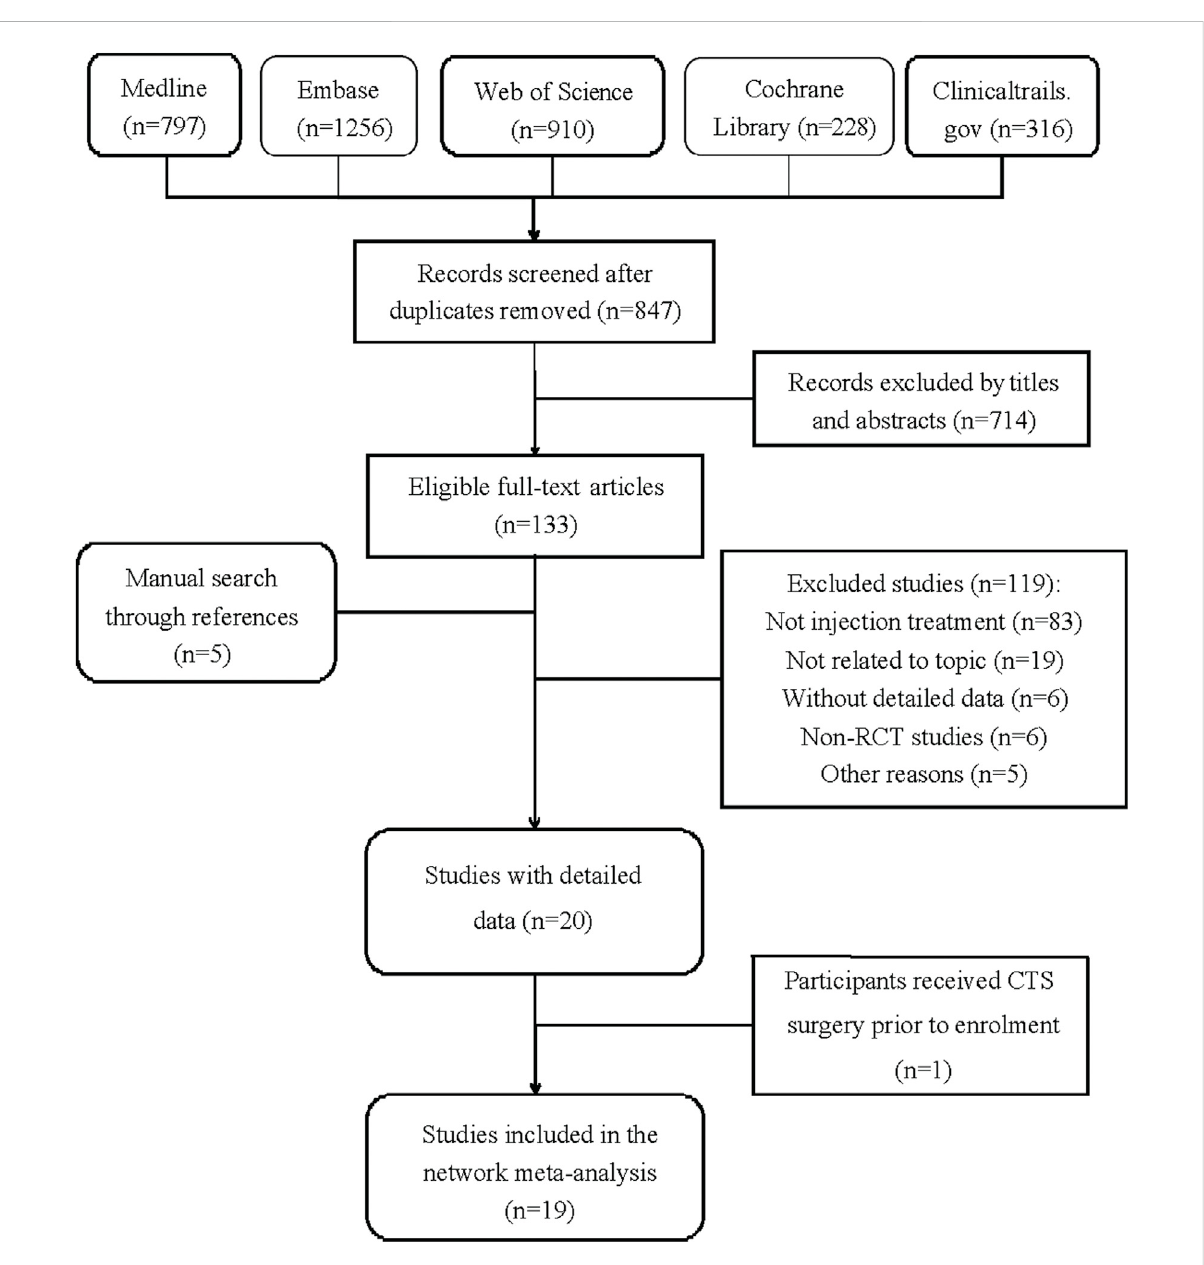
FIGURE 1 Flowchart of selection of the included